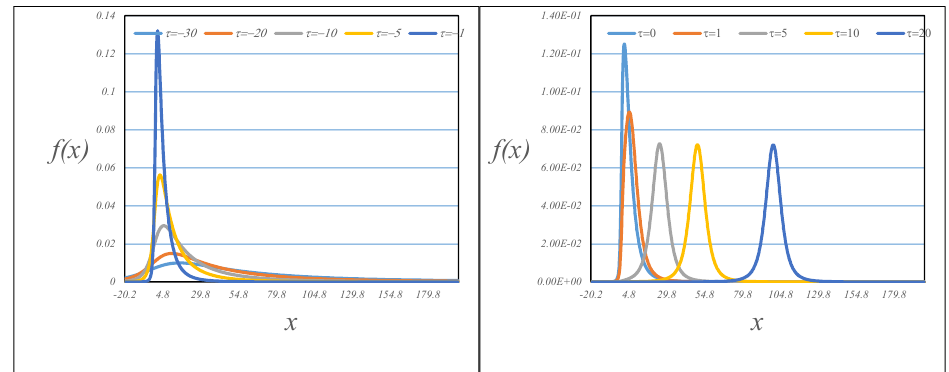
Figure 7. Extended skew-Student density functions, ν = 3, λ =